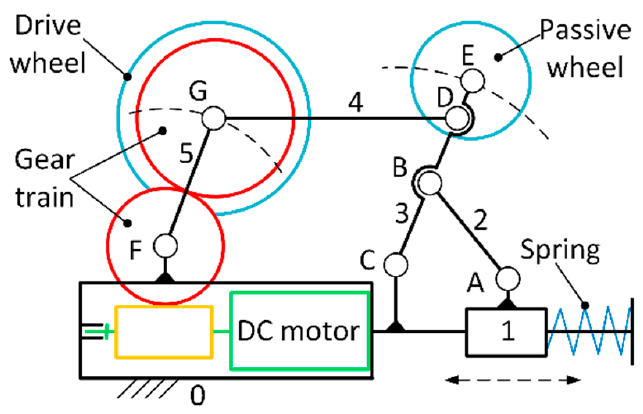
Figure 16. Passive adapting mechanism.